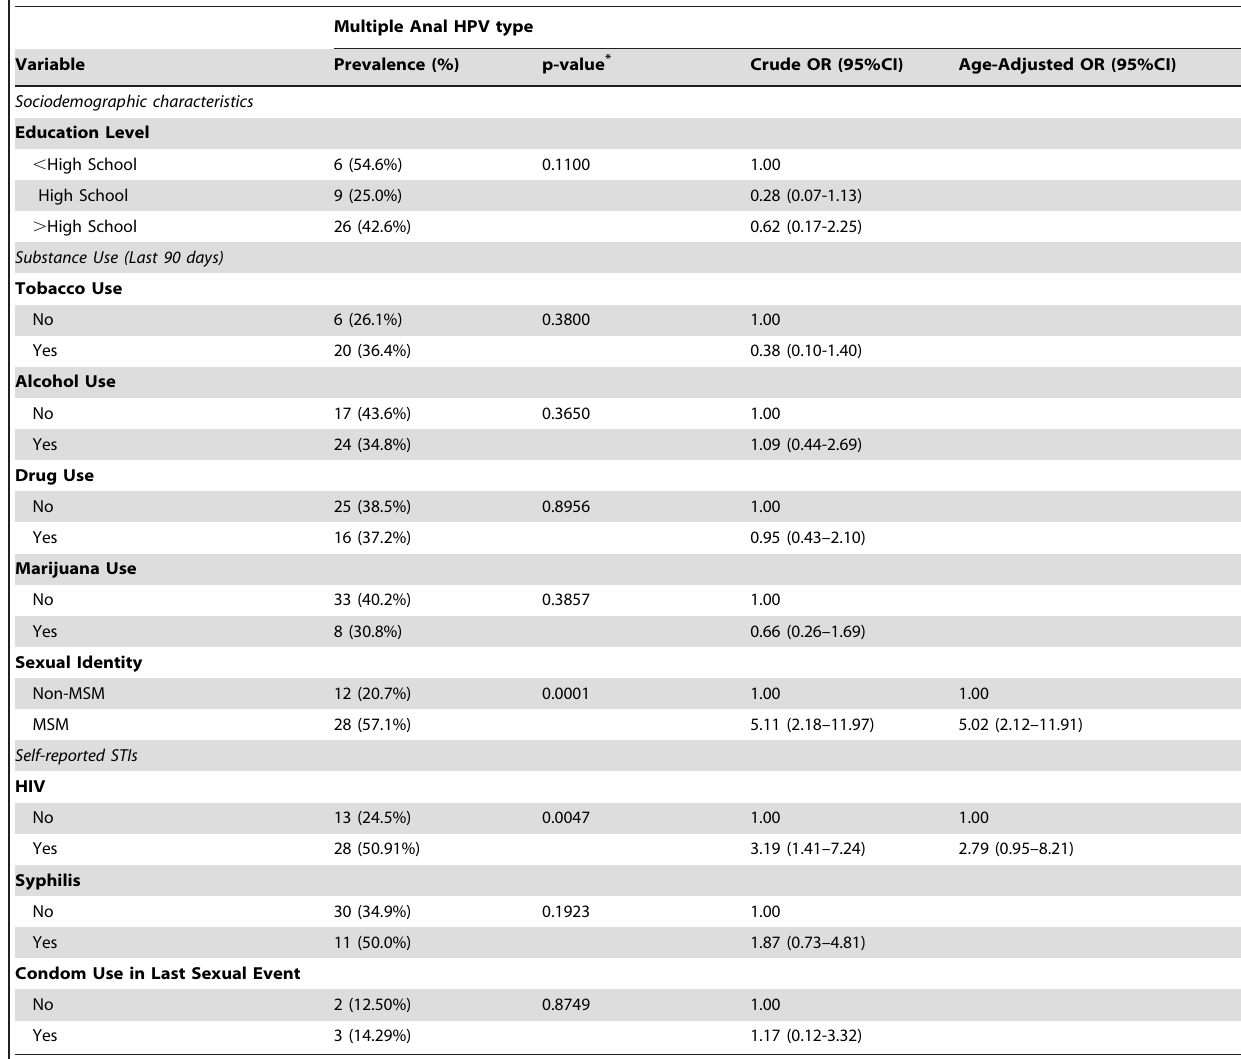
Table 5. Prevalence and Correlates Associated with Multiple Anal HPV